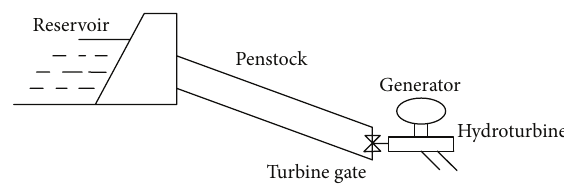
Figure 1: The physical model of penstock